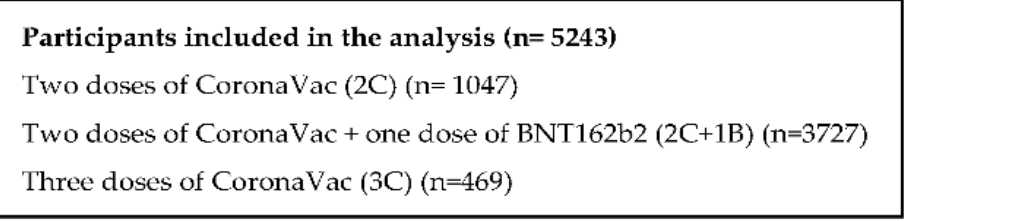
Figure 1. Flow diagram of the patient selection process.